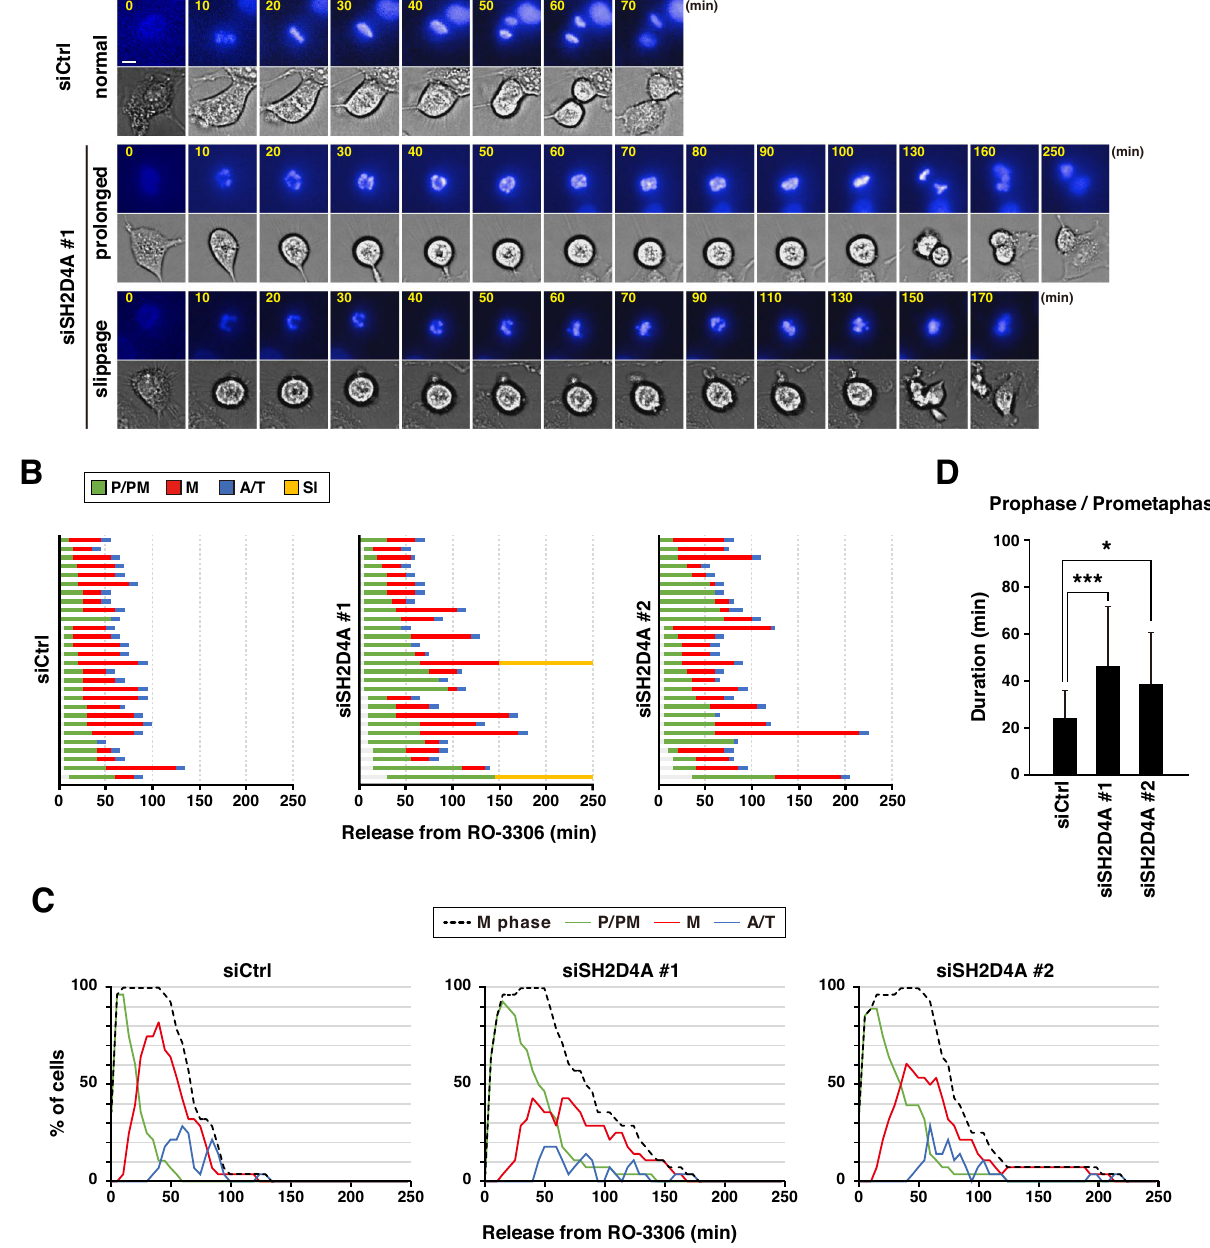
Figure 2. SH2D4A knockdown prolongs prometaphase duration. ( A – D ) A549 cells were transfected with control siRNA (siCtrl) or SH2D4A-targeting siRNAs (siSH2D4A #1 and #2). At 28 h after siRNA transfection, cells were treated with 6 µM RO-3306 for 20 h and washed with PBS(+). Then, the cells were monitored for 250 min by time-lapse imaging with 0.1 µM Hoechst 33342. ( A ) Images show typical phenotypes of siRNA- treated mitotic cells: cells that exhibit normal mitosis (normal mitosis), the prolonged-duration of prophase/ prometaphase (prolonged), and the mitotic exit without chromosome segregation (slippage). Scale bar, 10 µm. ( B ) The duration of each mitotic phase is shown: prophase/prometaphase (P/PM: from nuclear envelope breakdown to chromosome condensation, green), metaphase (M: chromosome alignment, red), anaphase/ telophase (A/T: from anaphase onset to cleavage furrow ingression, blue), and slippage (Sl: interphase cells that undergo mitotic slippage, yellow). In total, 28 mitotic cells were examined. ( C ) The percentages of mitotic cells (black), prophase and prometaphase (green), metaphase (red), and anaphase and telophase cells (blue) at the indicated times are plotted. ( D ) The duration time of prophase/prometaphase in each group is plotted as the mean ± SD from a representative experiment of two independent experiments. Asterisks indicate significant differences (Dunnett’s test, * p < 0.05, *** p <